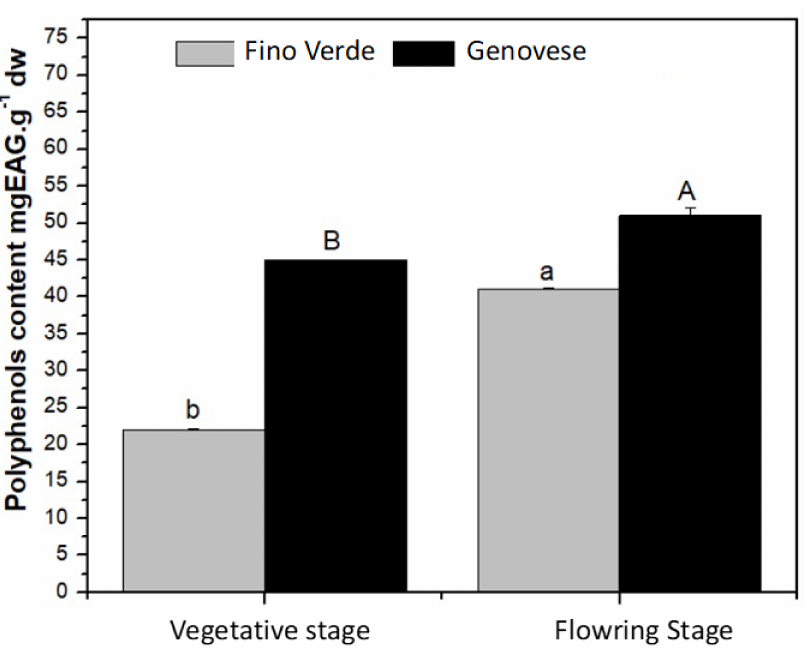
Figure 1. Polyphenols and flavonoids content of two varieties in different stage. Values are repre- sented by mean ± standard deviation of at least three independent replicates. Within the same stage, different letters on the bars indicate significant differences at p < 0.05.